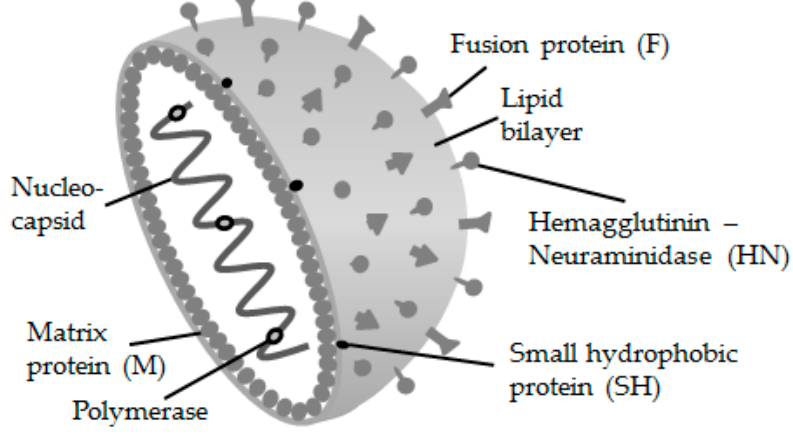
Figure 1. Structure of the mumps virus. The helical nucleocapsid consists of the nucleoprotein and